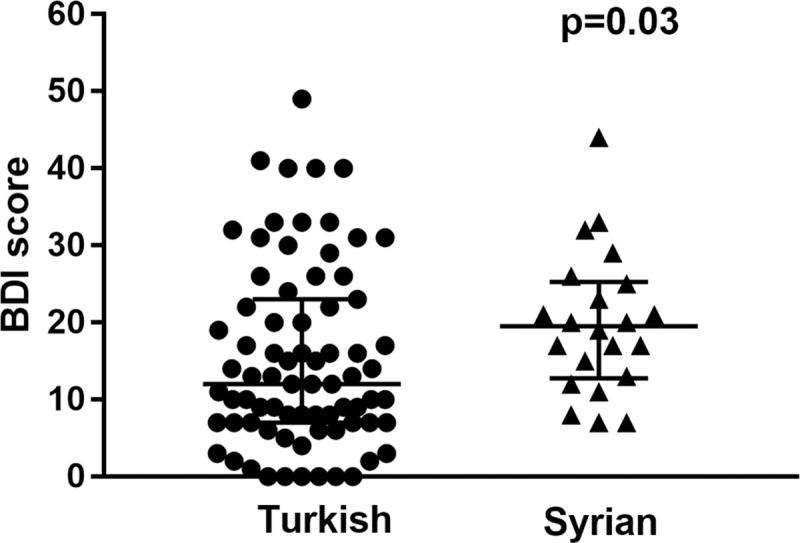
Distribution of BDI scores for nationalities.Every circle represents a Turkish, a triangle represents a Syrian patient. The median BDI score was 12 (7–23) for Turkish patients, 19.5 (12.7–25.2) for Syrian patients (p = 0.03).